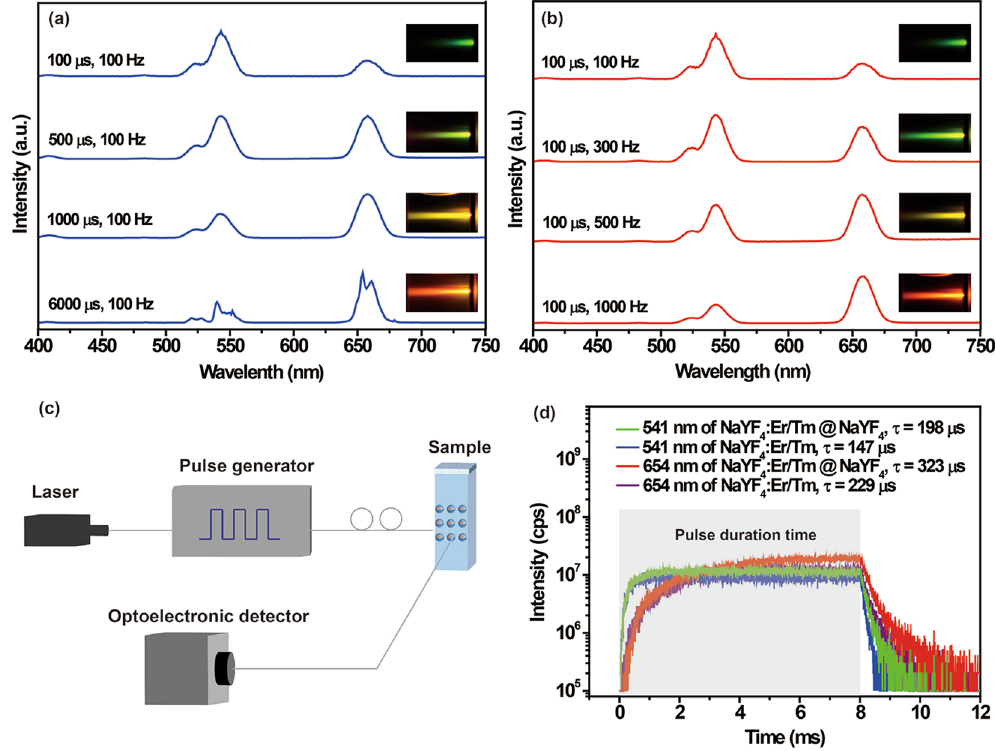
Figure 3. Temporal control of upconversion luminescence. ( a–b ) Photoluminescence spectra of NaYF 4 :Er/ Tm@NaYF 4 nanocrystals under pulse 980 nm diode laser excitation: ( a ) x µ s, 100 Hz (x = 100, 500, 1000, 6000) and ( b ) 100 µ s, y Hz (y = 100, 300, 500, 1000); ( c ) Experimental setup for upconversion spectra detection under pulsed 980 nm laser excitation and lifetime measurement; ( d ) Time-dependent evolutions of emission intensity at 541 nm and 654 nm of NaYF 4 :Er/Tm and NaYF 4 :Er/Tm@NaYF 4 nanocrystals showing the rising time and decay